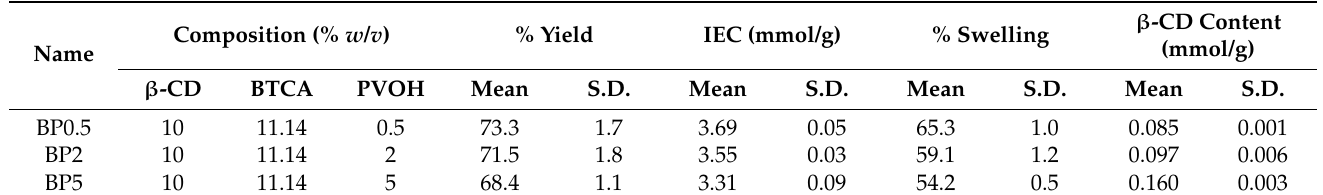
Table 1. Physicochemical properties of cyclodextrin nanosponges and their derivatives.